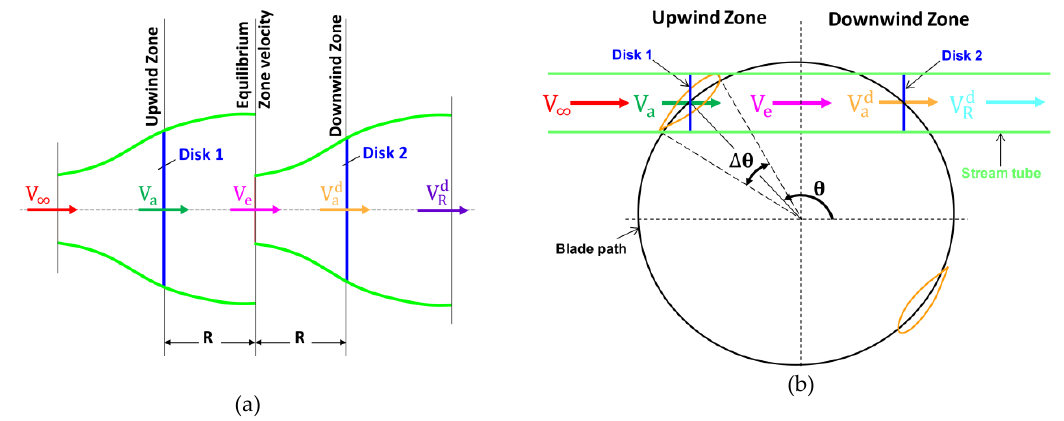
Figure 6. ( a ) Shematic of two-actuator disk in tandem ( b ) Diagrammatic of DMST model. Table 1. Comparison of aerodynamic models